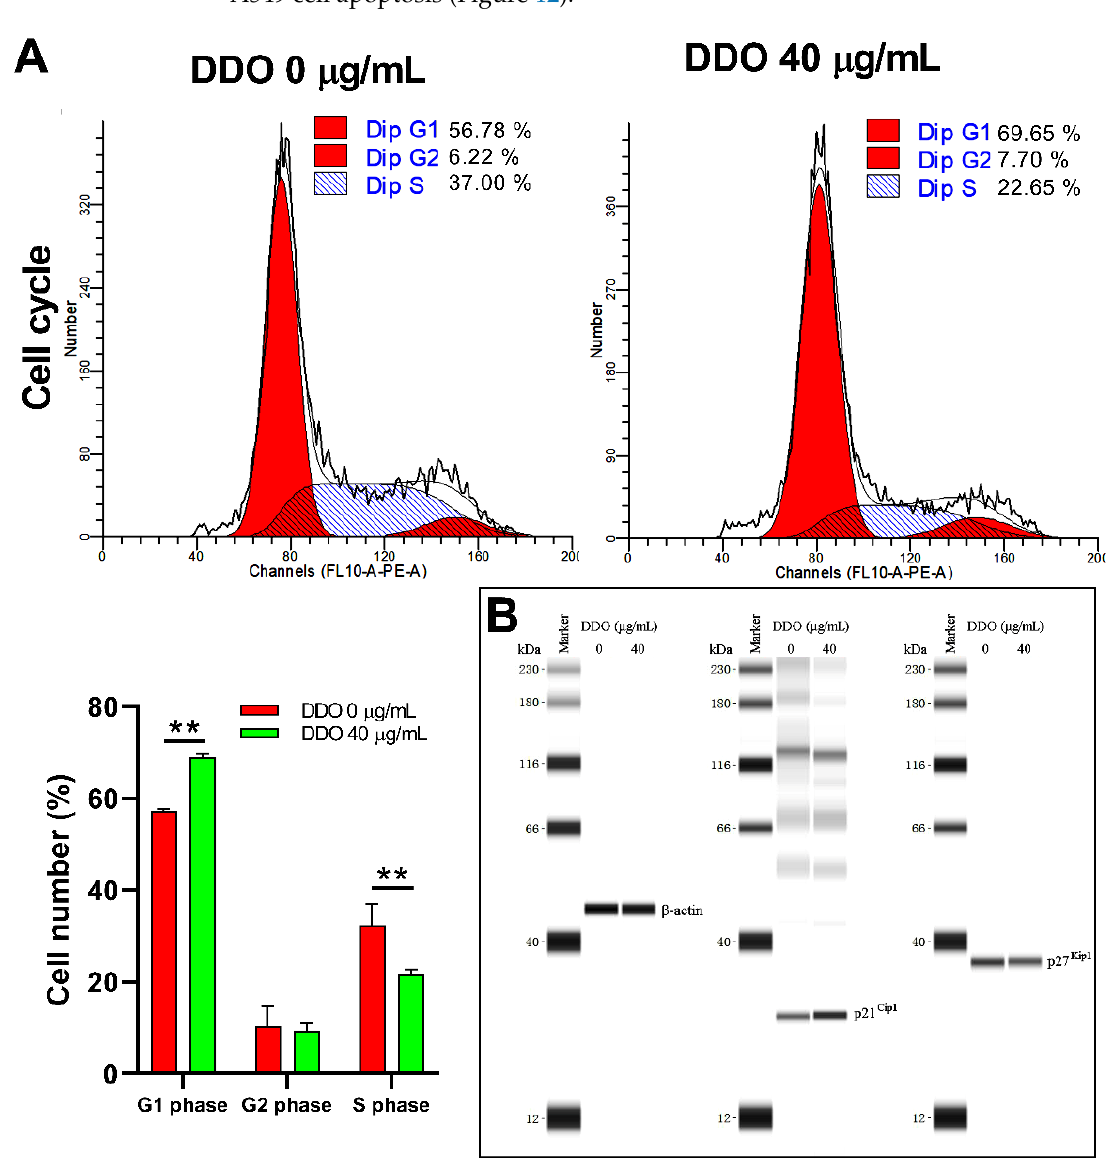
Figure 11. Cell cycle analysis of A549 cells treated with DDO. ( A ) A549 cells were treated with DDO (40 µg/mL) for 24 h; cells were fixed and stained with PI/RNase Staining Buffer for 30 min. The cell cycle distributions were analyzed on a Cytoflex S flow cytometer. ( B ) Expression levels of p21 Cip1 and p27 Kip1 in A549 cells treated with DDO (40 µg/mL) were detected on a Simple Wes System. The values represent mean ± standard deviation of three independent experiments. ** p < 0.01.